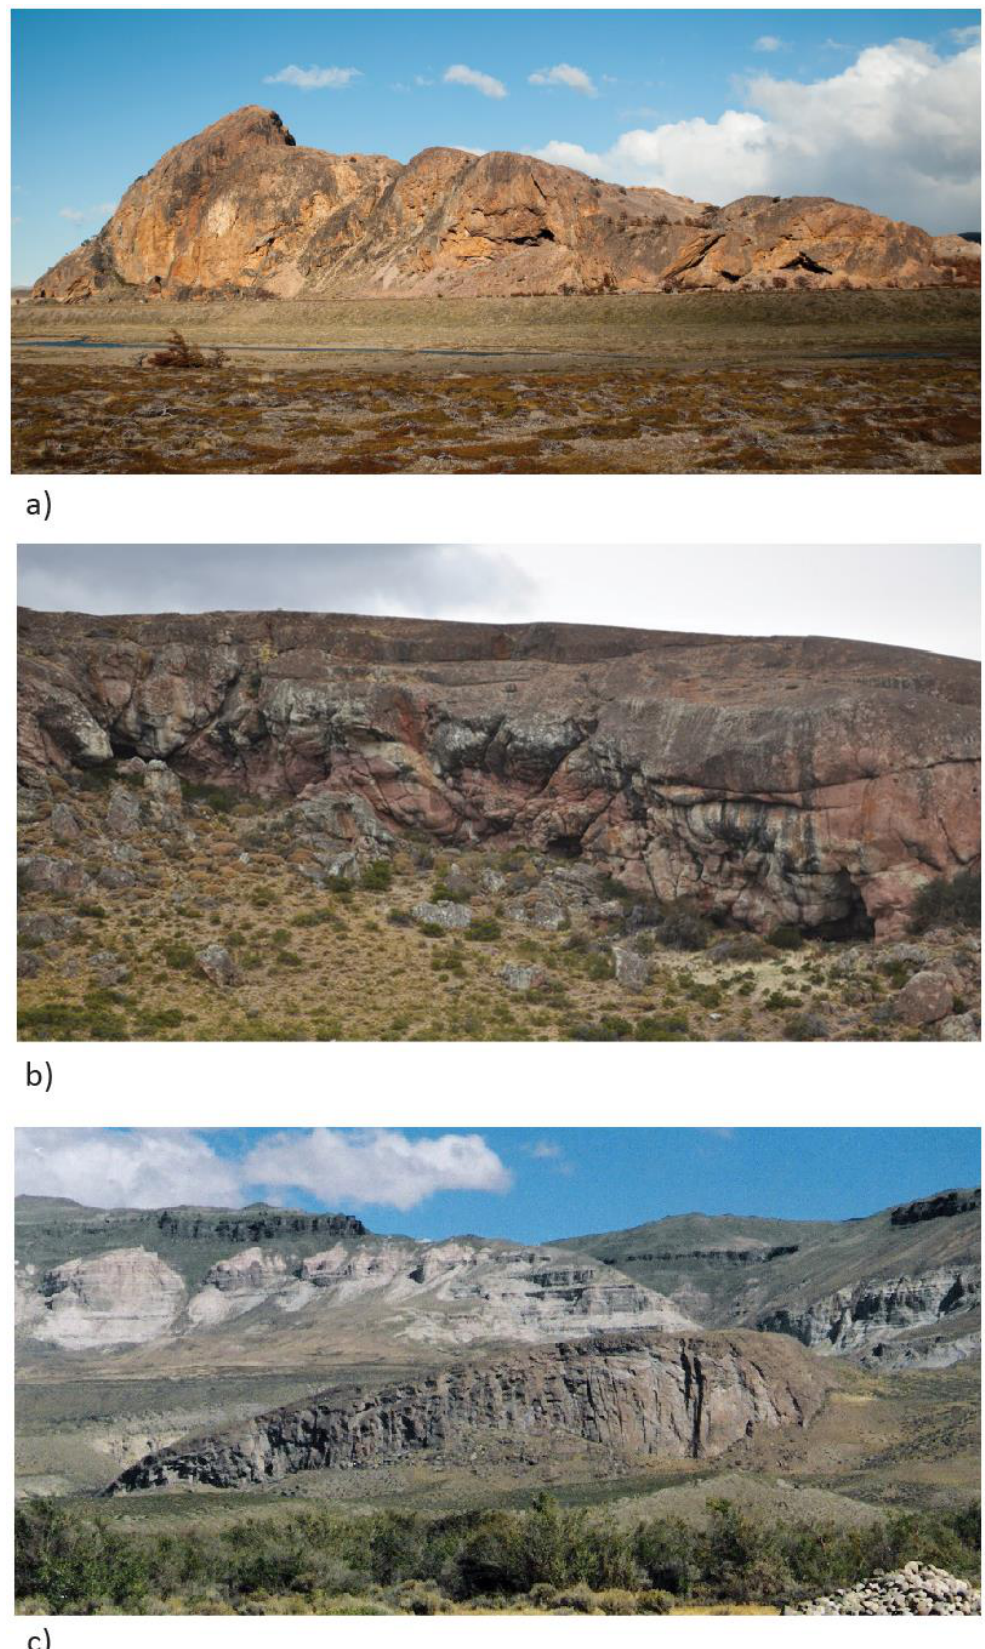
Figure 2. General view of a) Cerro Casa de Piedra 7 (Burmeister-Belgrano Basin), b) Cueva Milodon Norte 1 and c) Cerro de los Indios 1 (Pueyrredón-Posadas-Salitroso